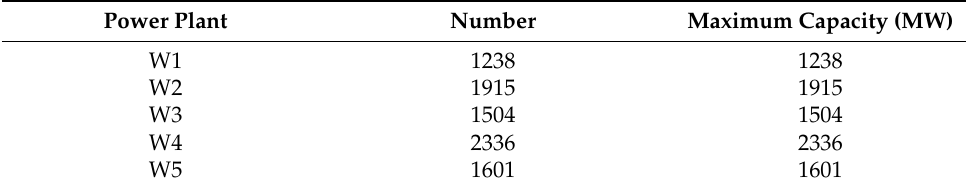
Table 2. Wind power installed capacity of the provincial power grid.